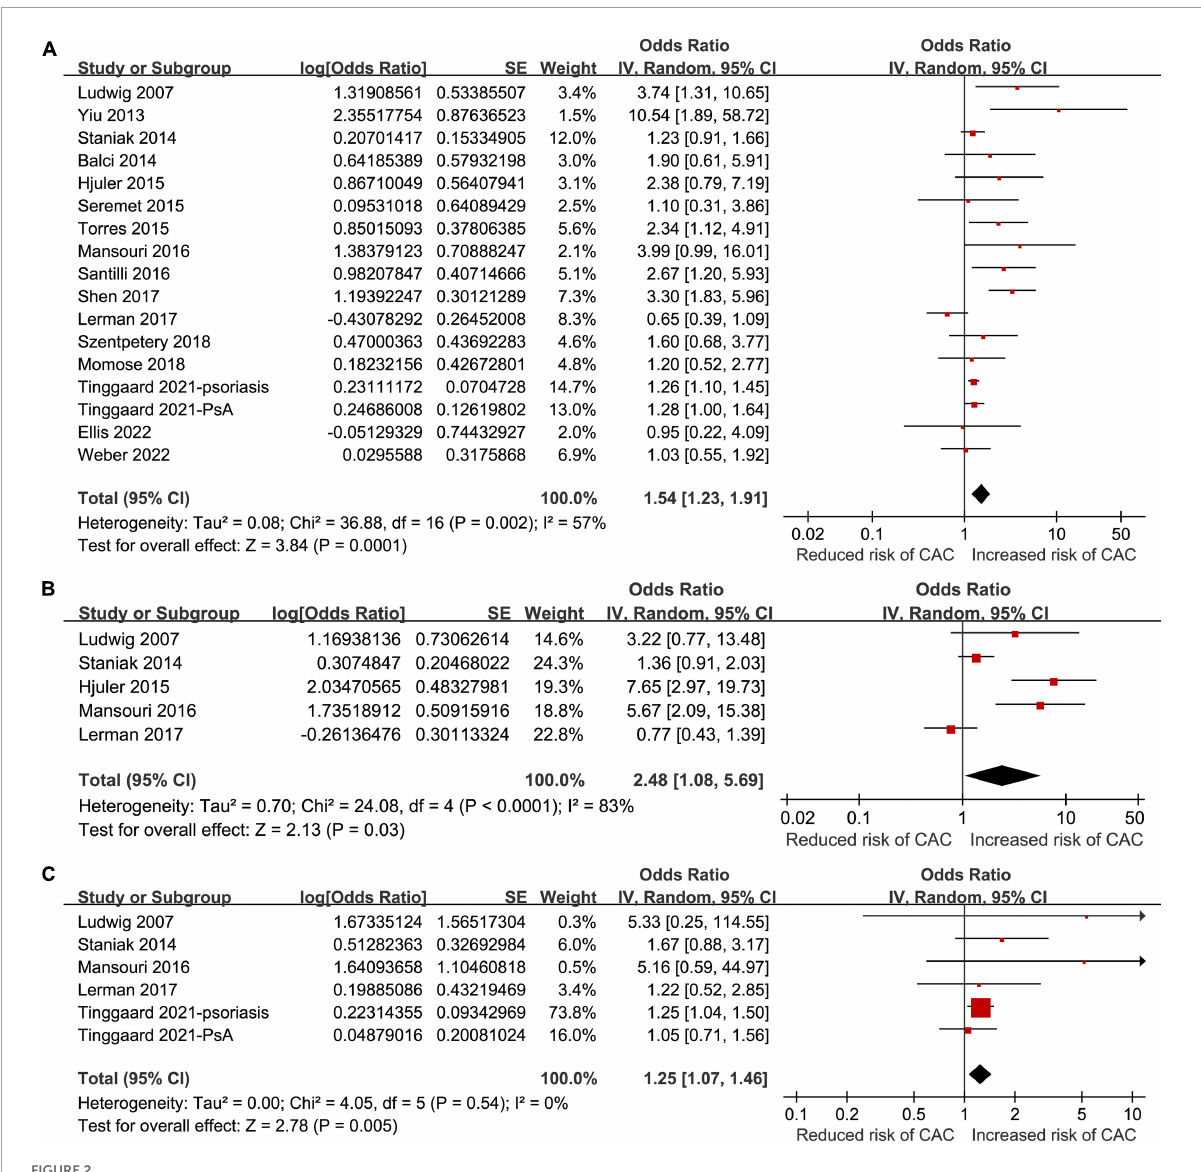
FIGURE2 Forest plots of the meta-analyses regarding the association between psoriasis and coronary artery calcification (CAC). (A) Meta-analysis of the presence of overall CAC. (B) Meta-analysis of the presence of moderate to severe CAC. (C) Meta-analysis of the presence of severe